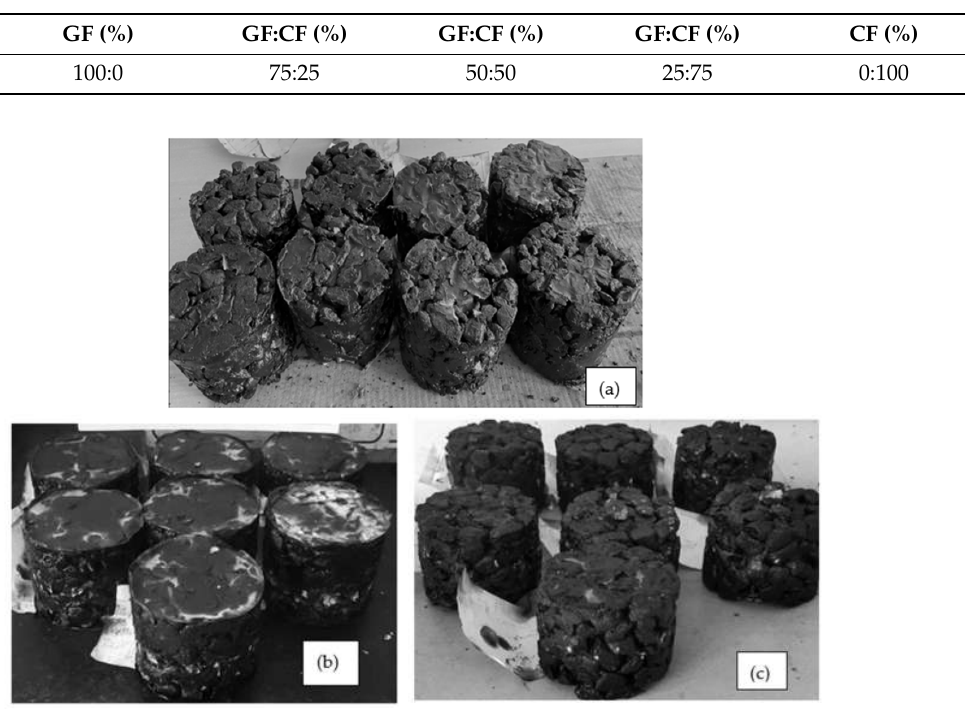
Figure 3. ( a – c ) Glass and carbon fiber with variation in fiber specimen ranging from 0–4.0%.